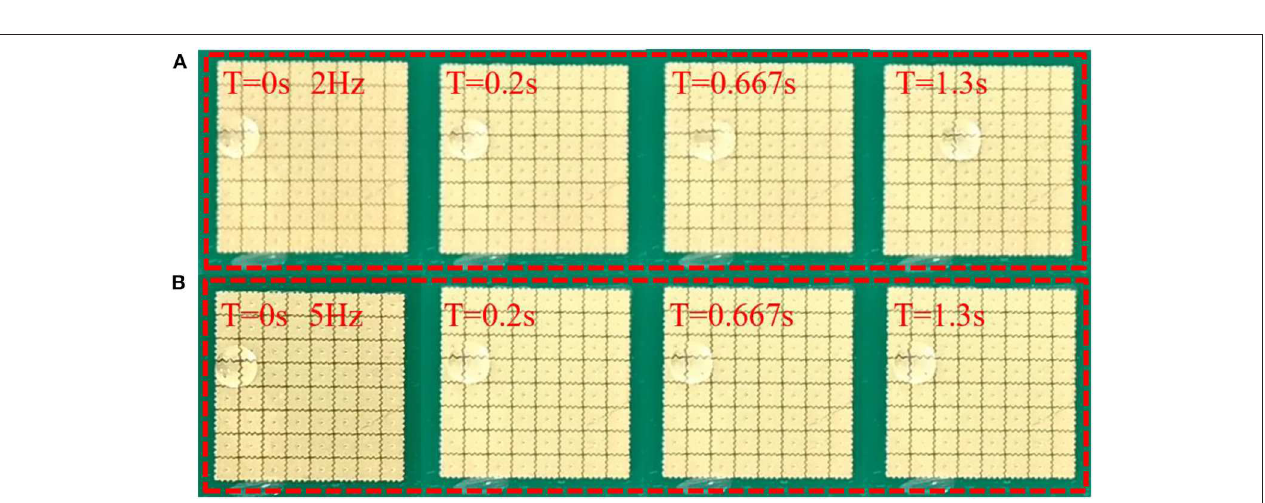
FIGURE 15 | When the droplet volume is 15 µ L, the comparison chart of droplets when the electrode switching frequency are 2 and 5Hz. (A) The droplet moved to the fourth electrode from the initial position after 1.3s when the electrode switching frequency is 2Hz. (B) The droplet has no movement from the initial position after 1.3s when the electrode switching frequency is